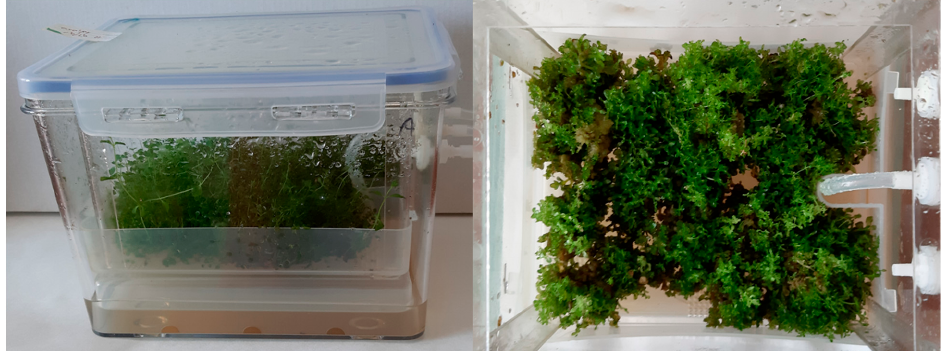
Figure 3. Microshoot in vitro culture of H. perforatum cv. Helos in the temporary immersion system (TIS): PlantForm bioreactors after a four-week growth cycle in a MS medium variant supplemented with 1.0 mg/L BAP and 1.0 mg/L NAA.